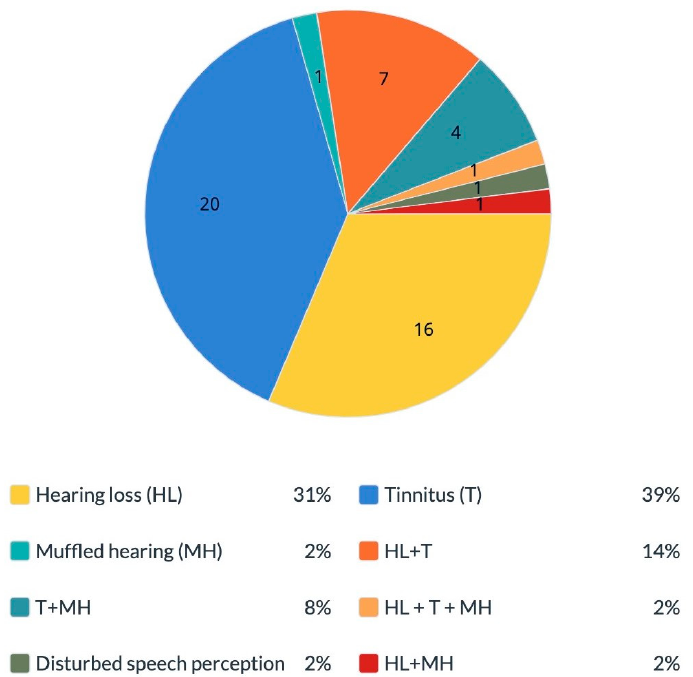
Figure 2. Hearing manifestations before silicone breast implant removal among women who under- went implant removal. The percentage of different hearing complaints among symptomatic women who complained of hearing impairments before they underwent silicone implant removal surgery. Total 100% is equal to n=51 subjects. HL—hearing loss; T—tinnitus; MH—muffled hearing. When we checked the women’s reports after they underwent silicone breast implant removal, we found that 24 (51%) reported no symptoms, 11 (23%) reported hearing loss and 4 (8.5%) reported tinnitus. Furthermore, two (4.2%) reported muffled hearing, four (8.5%) reported hearing loss combined with tinnitus, one (2.1%) reported a combination of the three complaints (hearing loss, tinnitus and muffled hearing) and one (2.1%) had “disturbed speech perception with multiple speakers” (Figure 3).